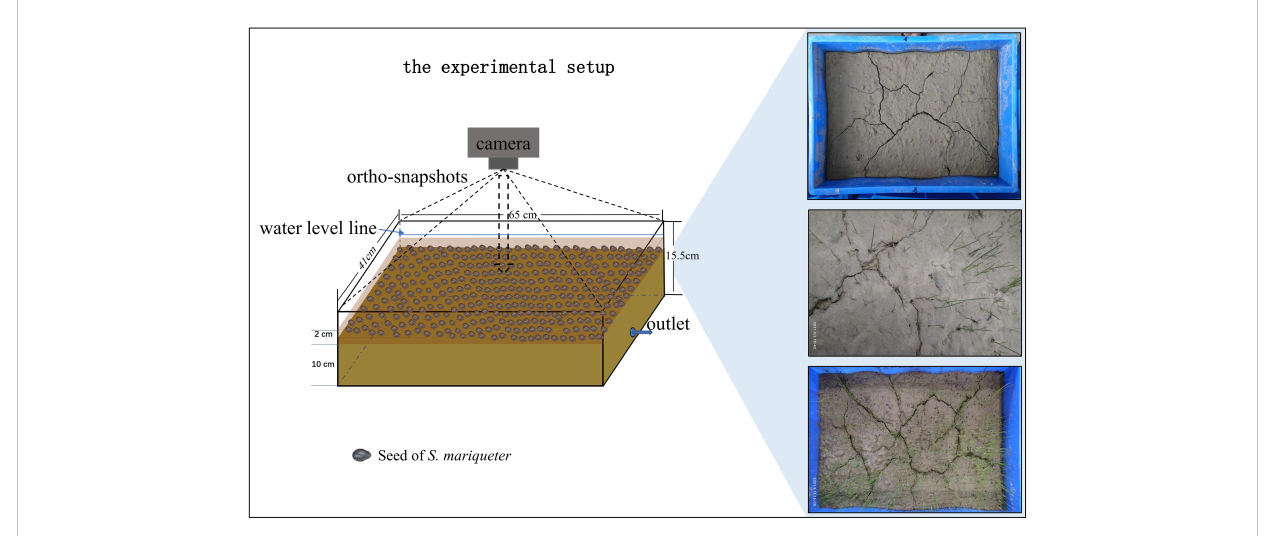
FIGURE 2 Manipulative control experiment and schematic representation of the experimental setup.